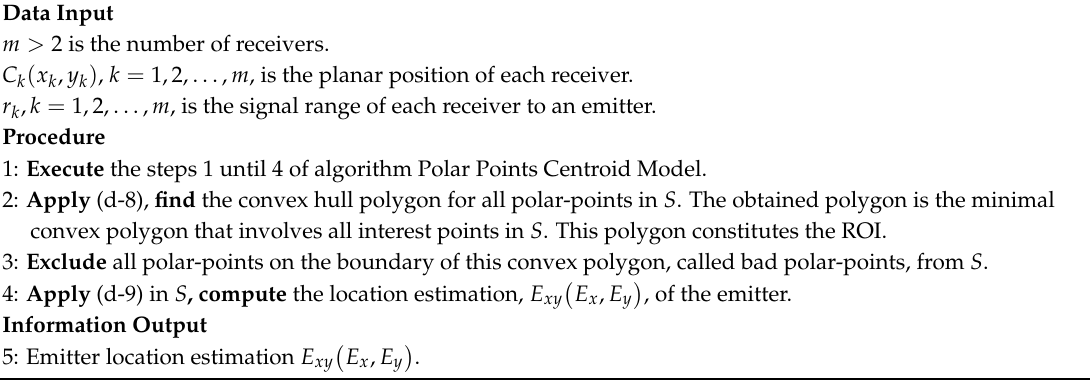
Algorithm 2. CHC—Convex Hull Centroid Model Algorithm Data Input